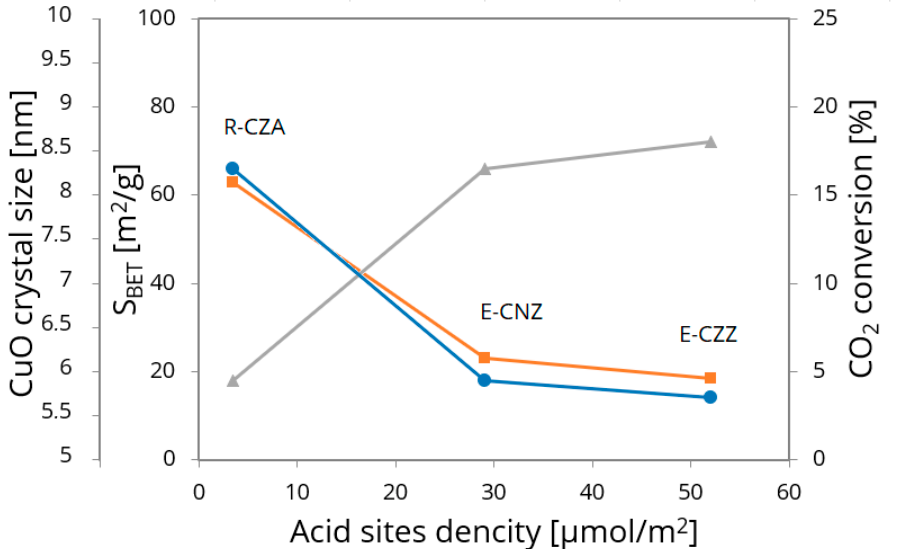
Figure 6. Relationship between BET surface area and acid sites density (orange), as well as CuO crystal size (grey), of prepared mixed oxide systems and their catalytic performance (blue) in comparison with reference catalyst.